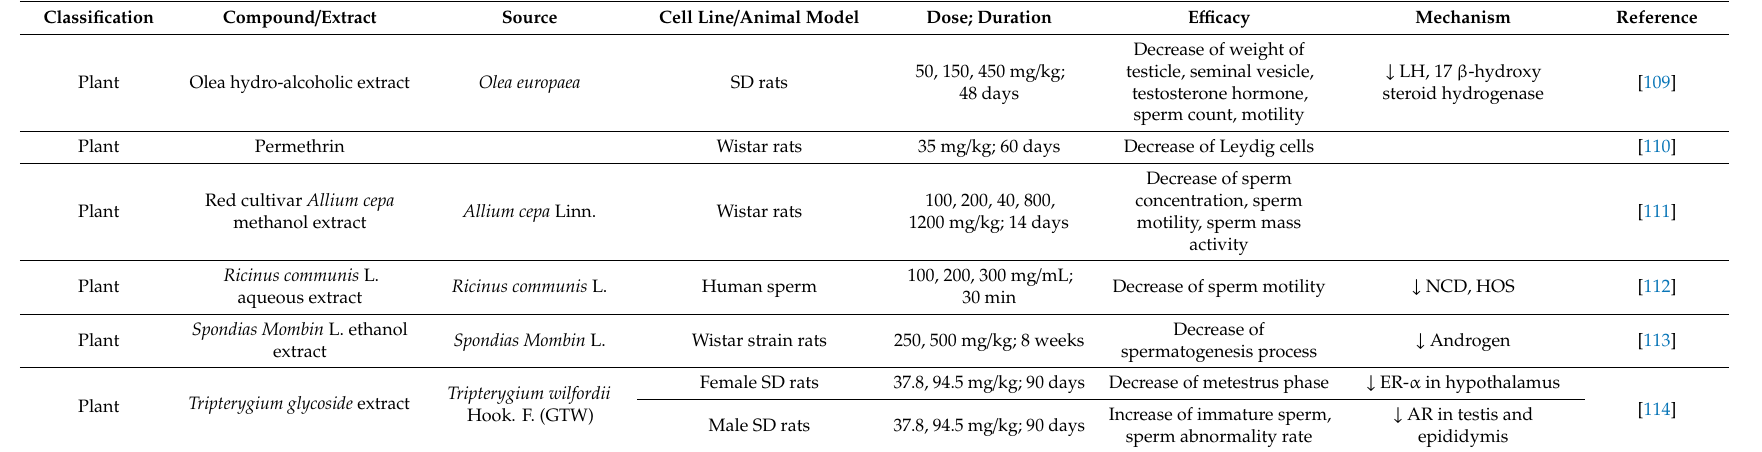
Table 11. Natural products with adverse e ff